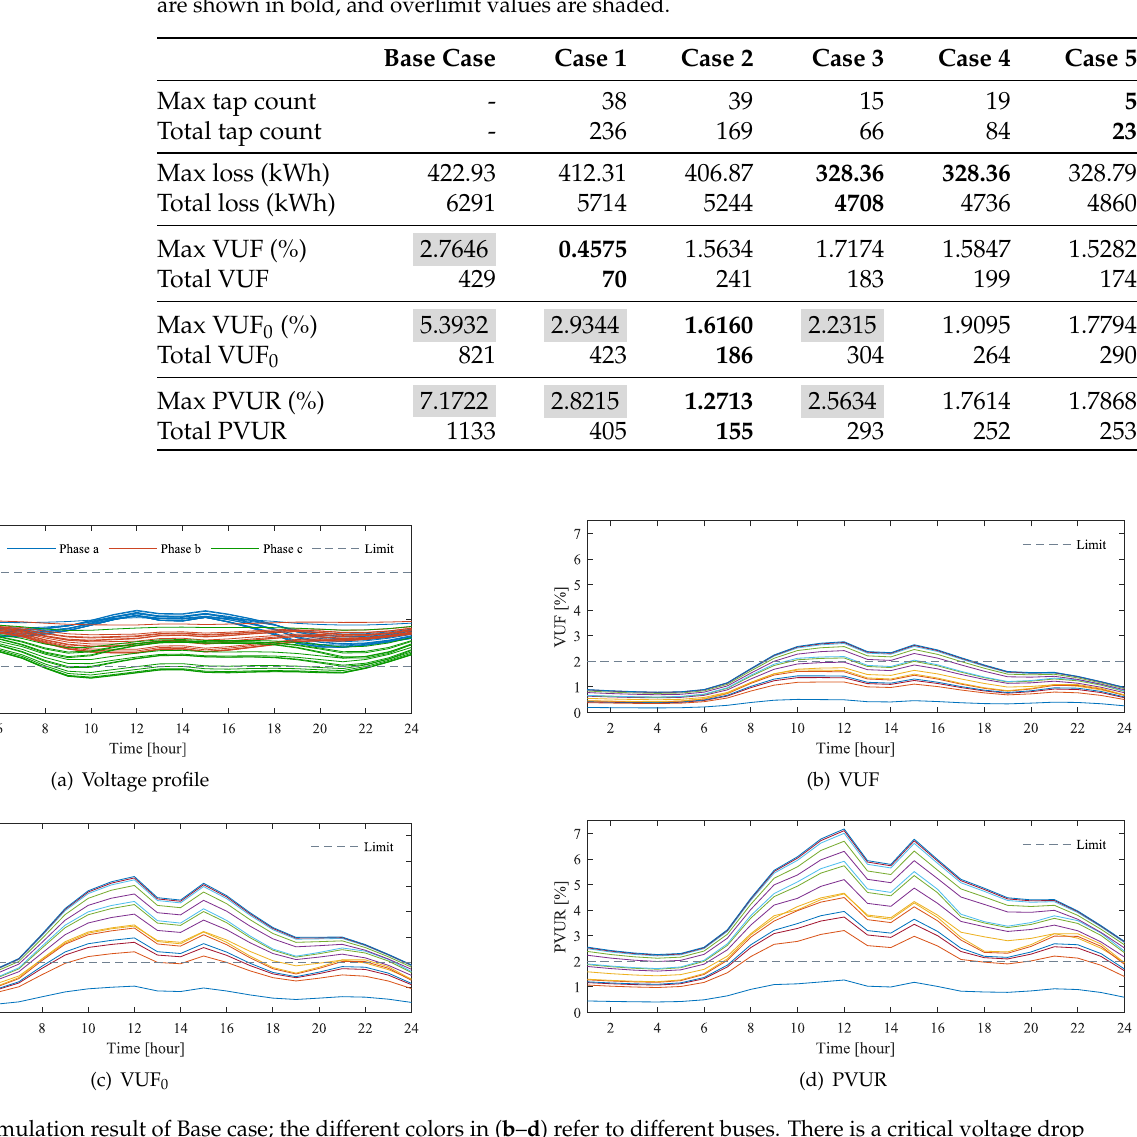
12 of 19 Table 1: Simulation results of unbalances, losses, and tap operations for all cases; the smallest values are shown in bold, and overlimit values are shaded.